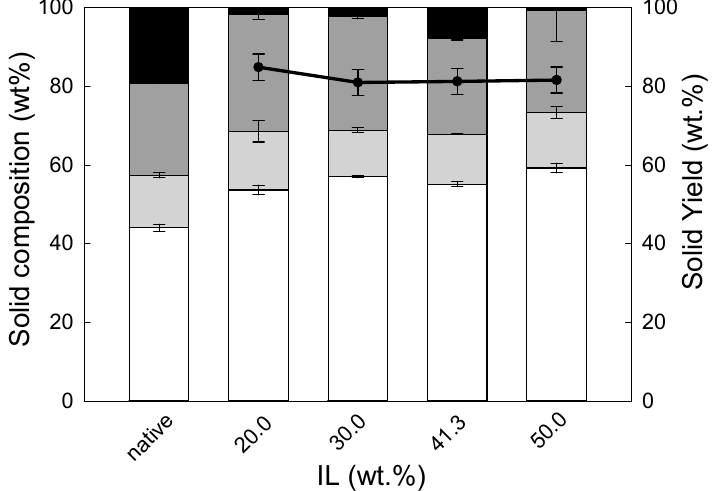
Figure 3. The solid phase composition (white bar–cellulose; light grey bar–hemicellulose; dark grey bar–Klason lignin; black bar–others) of eucalyptus residues pre-treatment at 140 °C and 90 min with [emim][HSO 4 ] at various % IL. The solid line represents the solid yield (wt.%) of pre-treated solids recovered after pre-treatment.